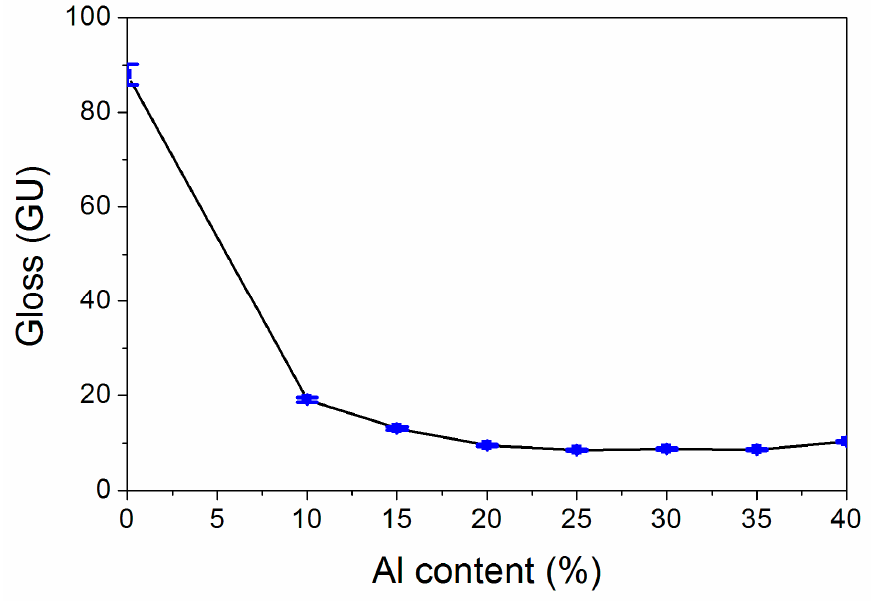
Figure 2. Influence of the Al powder concentration on gloss.